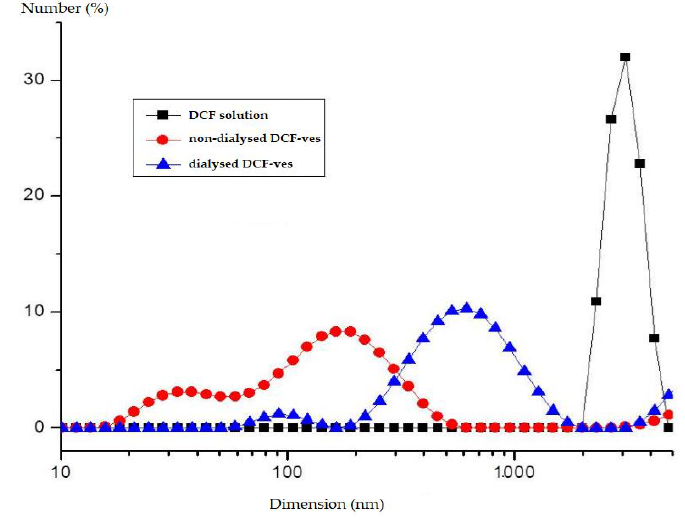
Figure 3. Size distribution of DCF-ves.